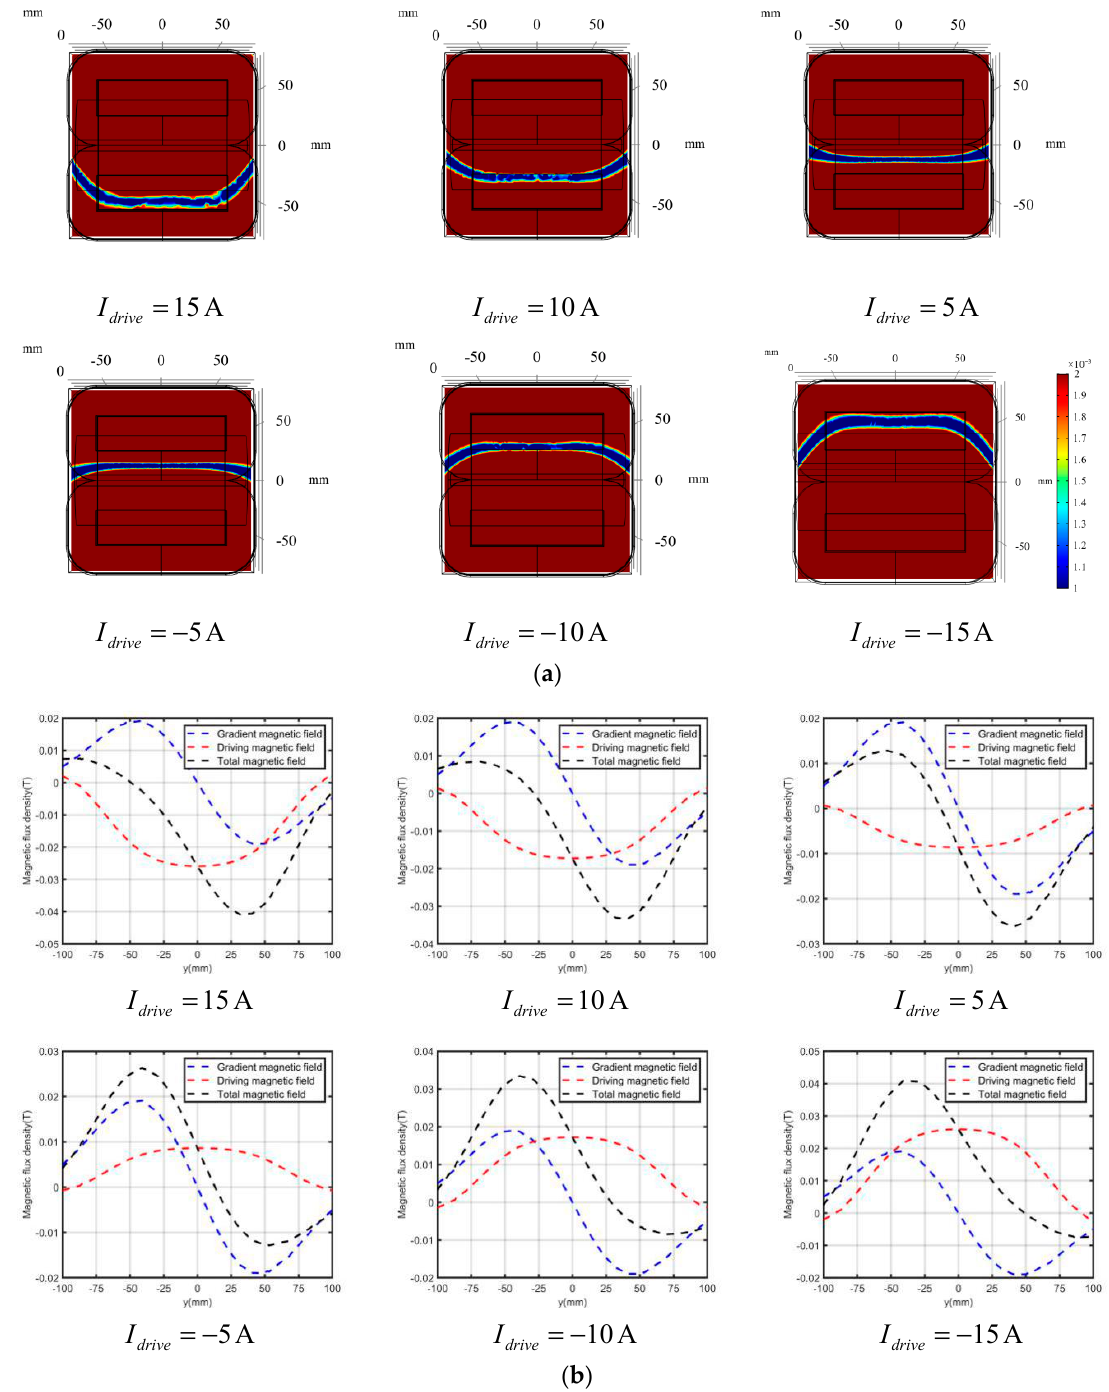
Figure 9. Distribution of magnetic fields with different driving currents. ( a ) position of zero magnetic field region; ( b ) Superposition of linearly gradient magnetic fields with different driving magnetic fields.